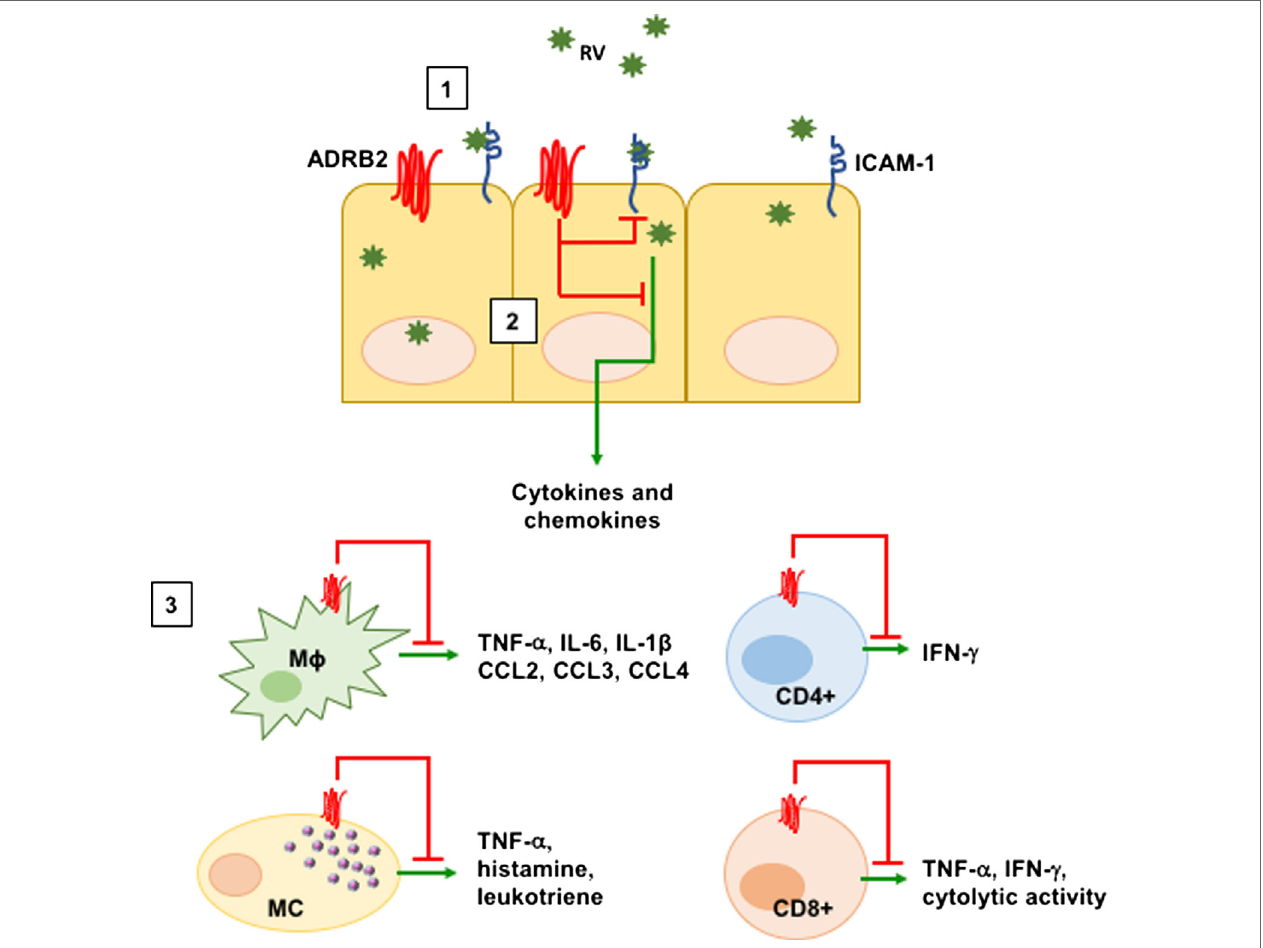
FiGUre 1 | ADRB2-mediated suppression of inflammatory processes. Adrenergic signaling through the ADRB2 inhibits various virus-induced immune mediators. [1] Rhinovirus (RV) infects the upper airways by binding to ICAM-1 on the surface of lung ECs. RV infection of ECs upregulates ICAM-1 as well as IL-8, IL-6, CCL5, CCL11, and CXCL10 to recruit inflammatory cells. [2] Activation of the ADRB2 by either the natural ligands epinephrine and norepinephrine or by β 2-agonists downregulates ICAM-1 as well as IL-8, CCL5, and GM-CSF from ECs. [3] ADRB2 signaling additionally inhibits pro-inflammatory mediators in innate and adaptive immune cells. Abbreviations: EC, epithelial cell; MC, mast cell; M ɸ ,